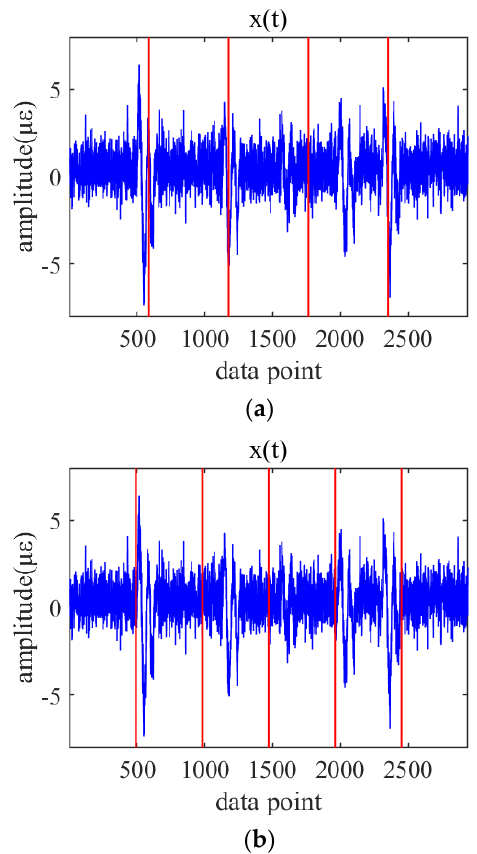
Figure 11. Signal division: ( a ) five segments ( b ) six segments. When the original signal is divided into five segments, the first, second, and fourth demarcation points are in the segments of the standard signal, where the signal character- istics are more volatile compared to the noisy signal and the amplitude changes signifi- cantly, resulting in generating more error and affecting the quality of the sifted signal. When the signal is divided into six segments, the demarcation point is in the smooth seg- ment of the signal, resulting in error being smaller. Through the above analysis, the